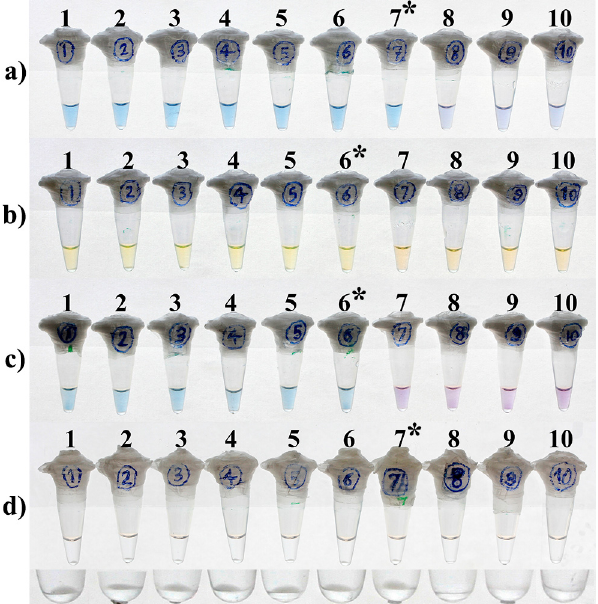
Figure 4. Comparison of the LOD of HNB-LAMP ( a ), Calcein-LAMP ( b ), EBT-LAMP ( c ), and turbidity-LAMP ( d ) for the diagnosis of TB. Tubes 1 to 10, respectively, contain 100 ng, 10 ng, 1 ng, 100 pg, 10 pg, 1 pg, 100 fg, 10 fg, 1 fg, and zero amount of Mtb DNA/reaction. The lower part of the figure shows the close-up view of ( d ) focused on the bottom of the tubes. The asterisks indicate the LOD of each method.